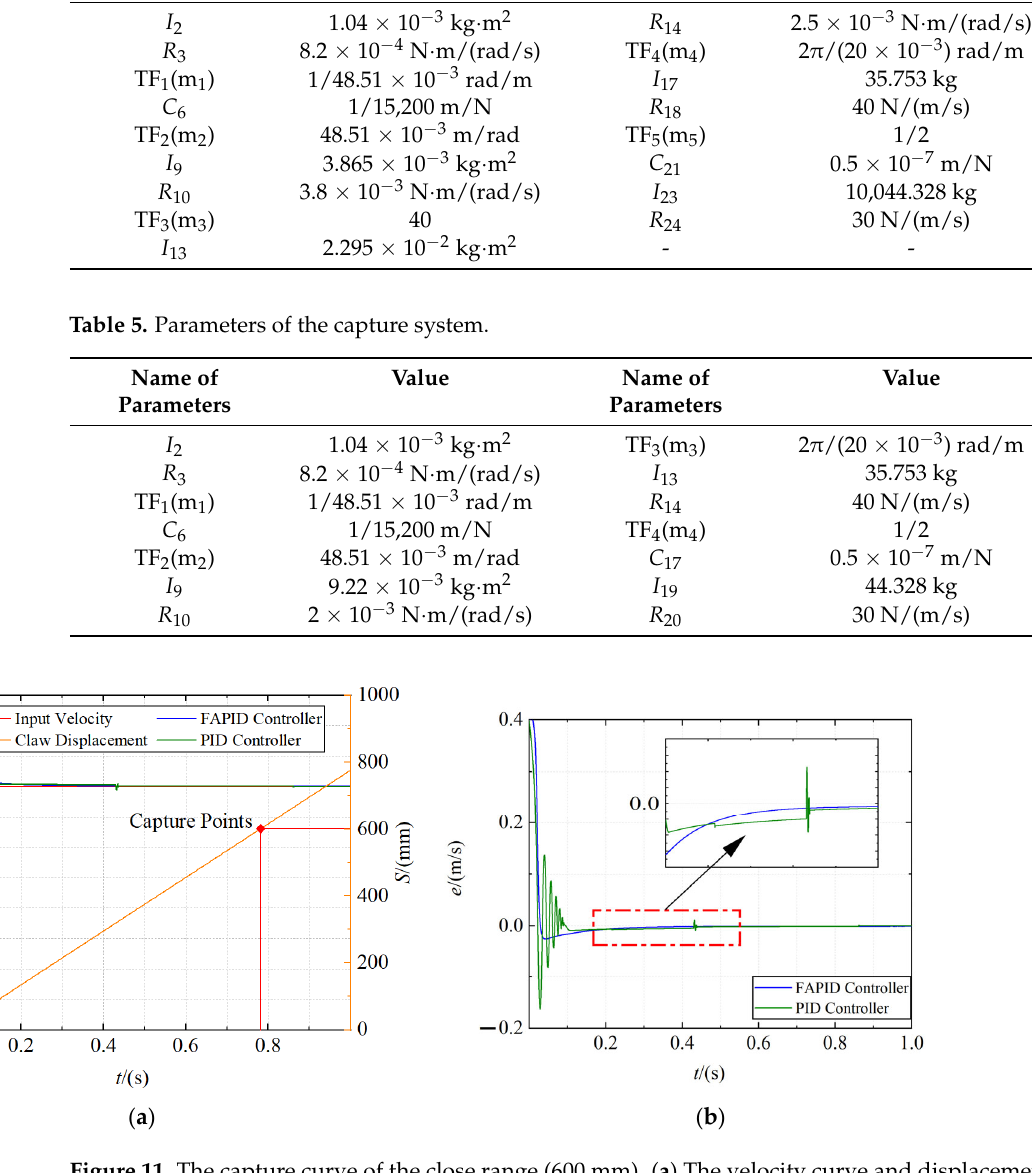
Figure 11. The capture curve of the close range (600 mm). ( a ) The velocity curve and displacement curve; ( b ) the error curve.